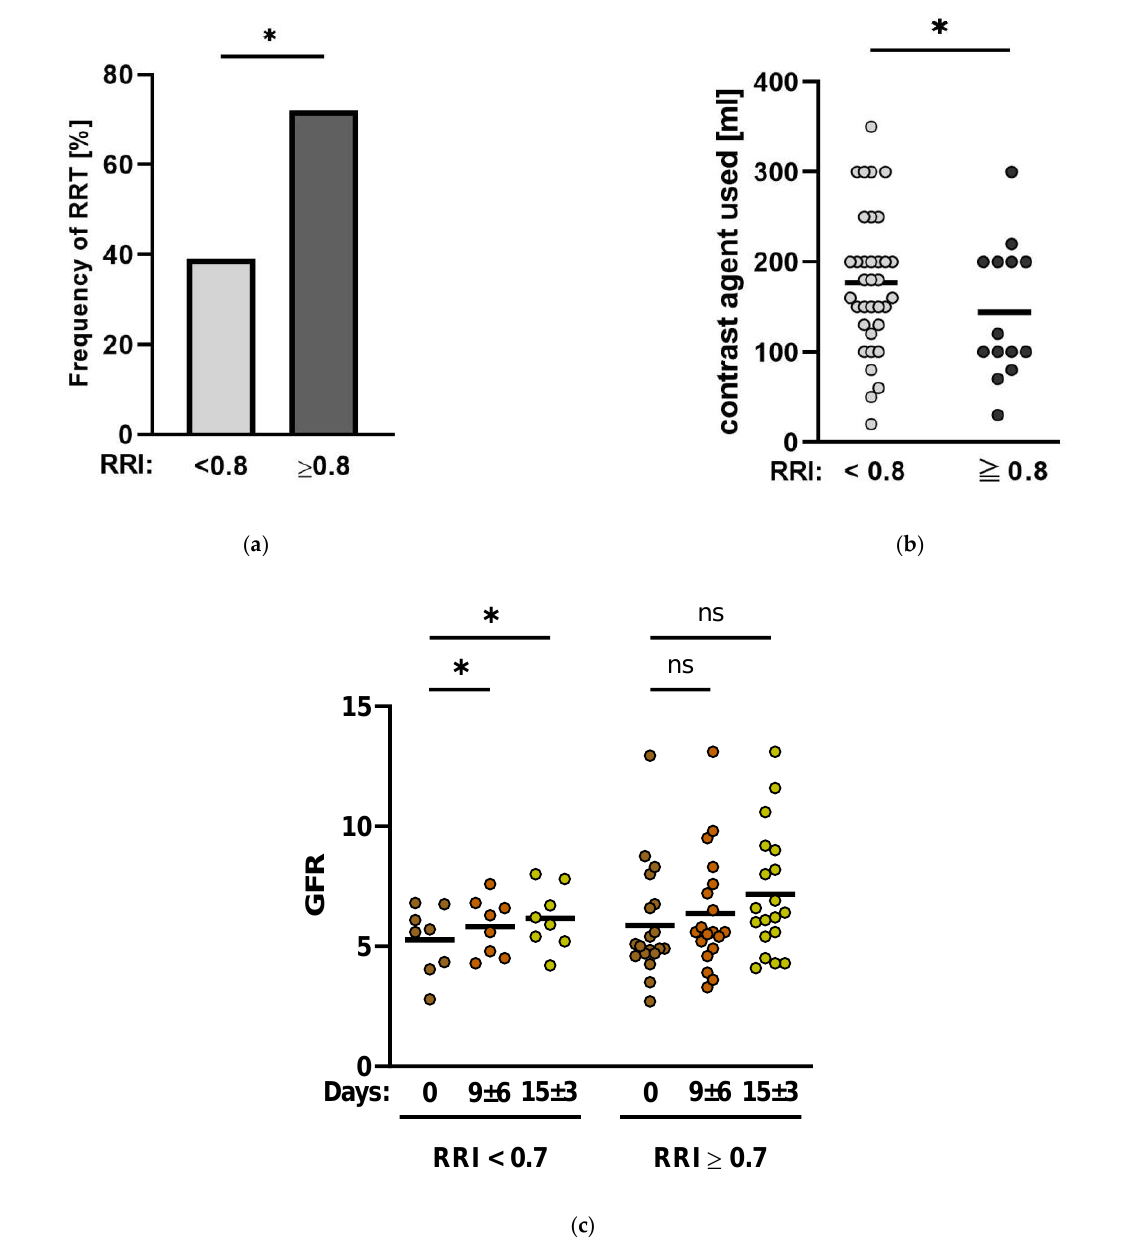
Figure 5. Renal organ function during Impella ® therapy. ( a ). Frequency of renal replacement therapy (RRT) by RRI. Patients with a baseline RRI ≥ 0.8 were accompanied by a significantly higher frequency of RRT than patients with a baseline RRI < 0.8 (71% vs. 39% p = 0.04). ( b ). Contrast agent exposition during initial intervention. ( c ). Short-term follow-up of GFR over a period of 15 ± 3 days. (GFR: glomerular filtration rate; ns: not significant, p ≥ 0.05; *: p < 0.05).